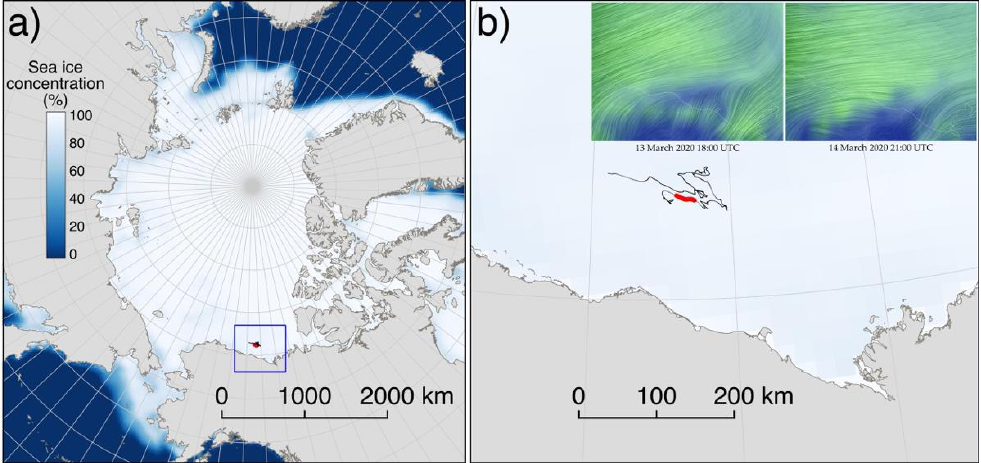
Figure 2. ( a ) Arctic sea ice concentration for March 2020 with blue square outlining the region shown at right. The nearest open water is in the Bering Sea, more than 1000 km distant. ( b ) Drift track of Camp Seadragon and insets of 13 March 2020 and 14 March 2020 wind lines directed southwest to northeast [earth.nullschool.net].